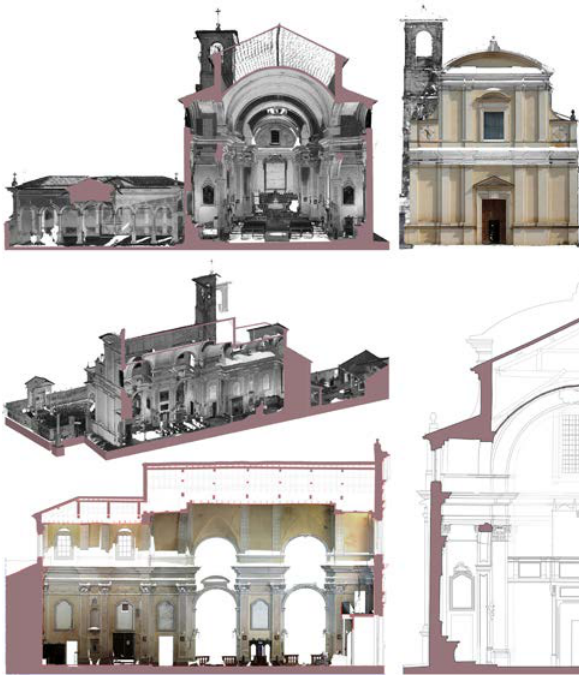
Figure 5. The complete documentation of a church of case 3: